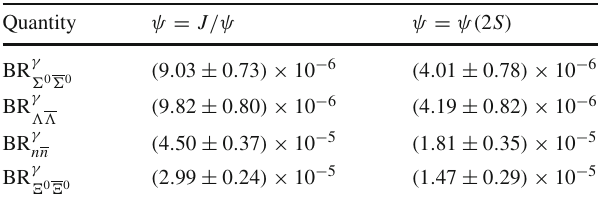
Table 3 Electromagnetic BRs computed through Eq. (11) and using the values of | D e | given in Eq. (9)